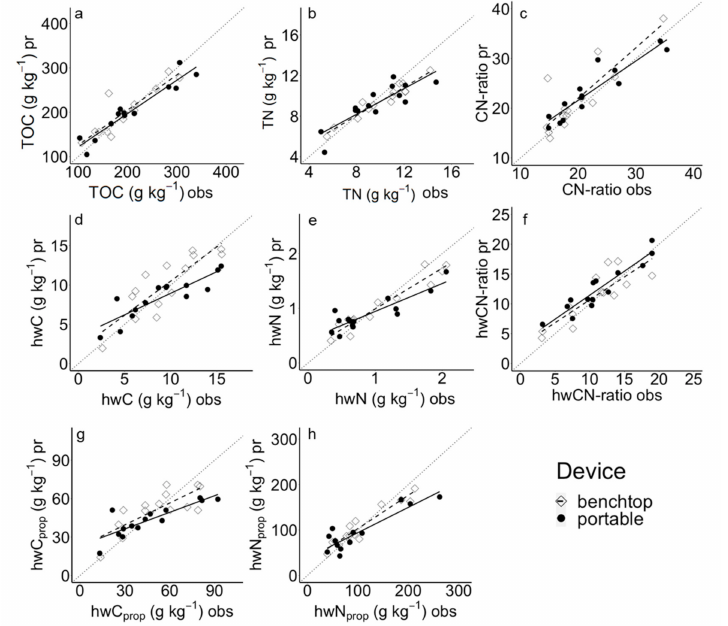
Figure 5. Test set validation: support vector machines (SVM) predicted (pr) and observed (obs) ( n = 14) values of benchtop and portable MIRS spectra for ( a ) TOC, ( b ) TN, ( c ) CN-ratio, ( d ) hwC, ( e ) hwN, ( f ) hw-CN-ratio, ( g ) proportion of hwC to TOC (hwC prop ), ( h ) proportion of hwN to TN (hwN prop ). While predictive models from bMIRS performed better for N pools, pMIRS models revealed a higher prediction accuracy and model robustness for the C and CN